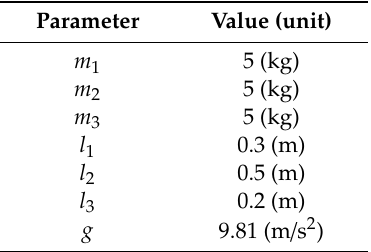
Table 3. The mechanical parameters used for simulations.